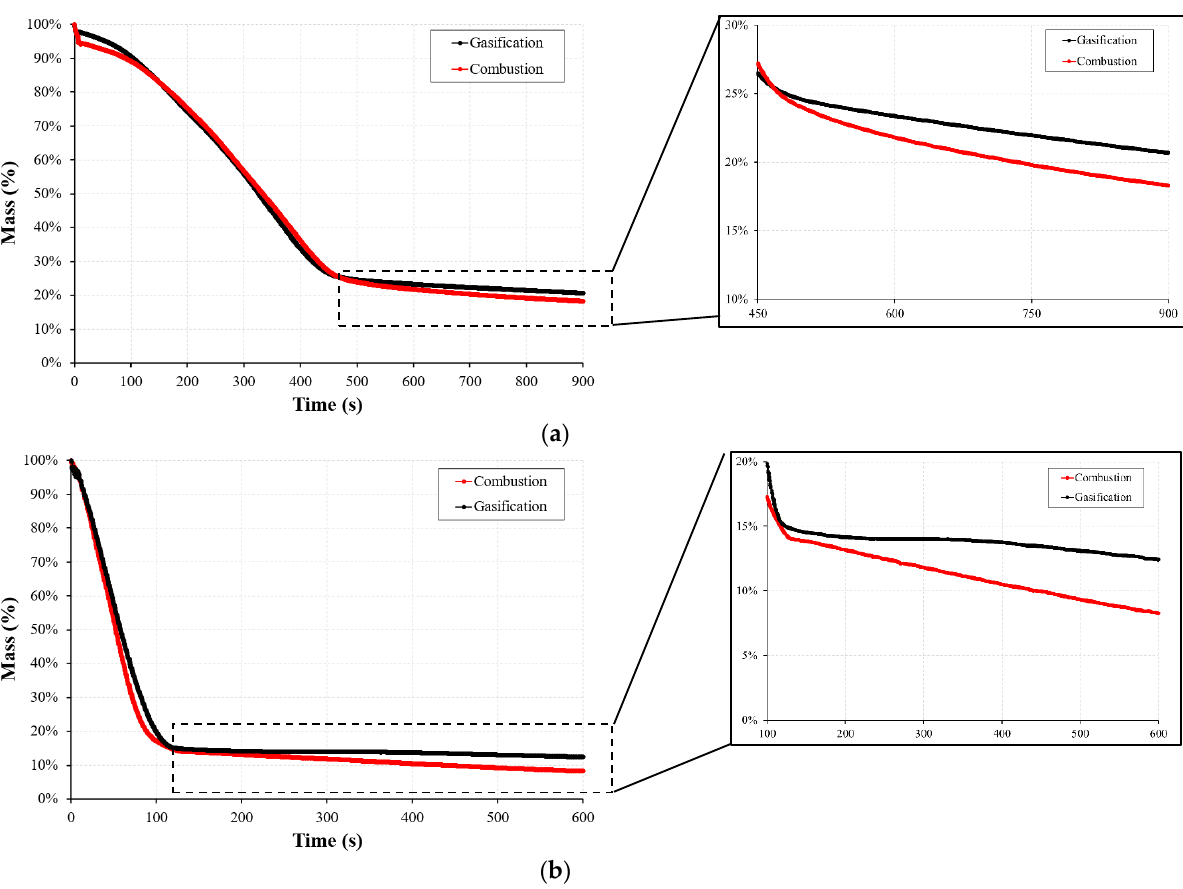
Figure 2. Mass loss curves considering the gasification and combustion regime at: ( a ) 400 °C and ( b ) 800 °C.